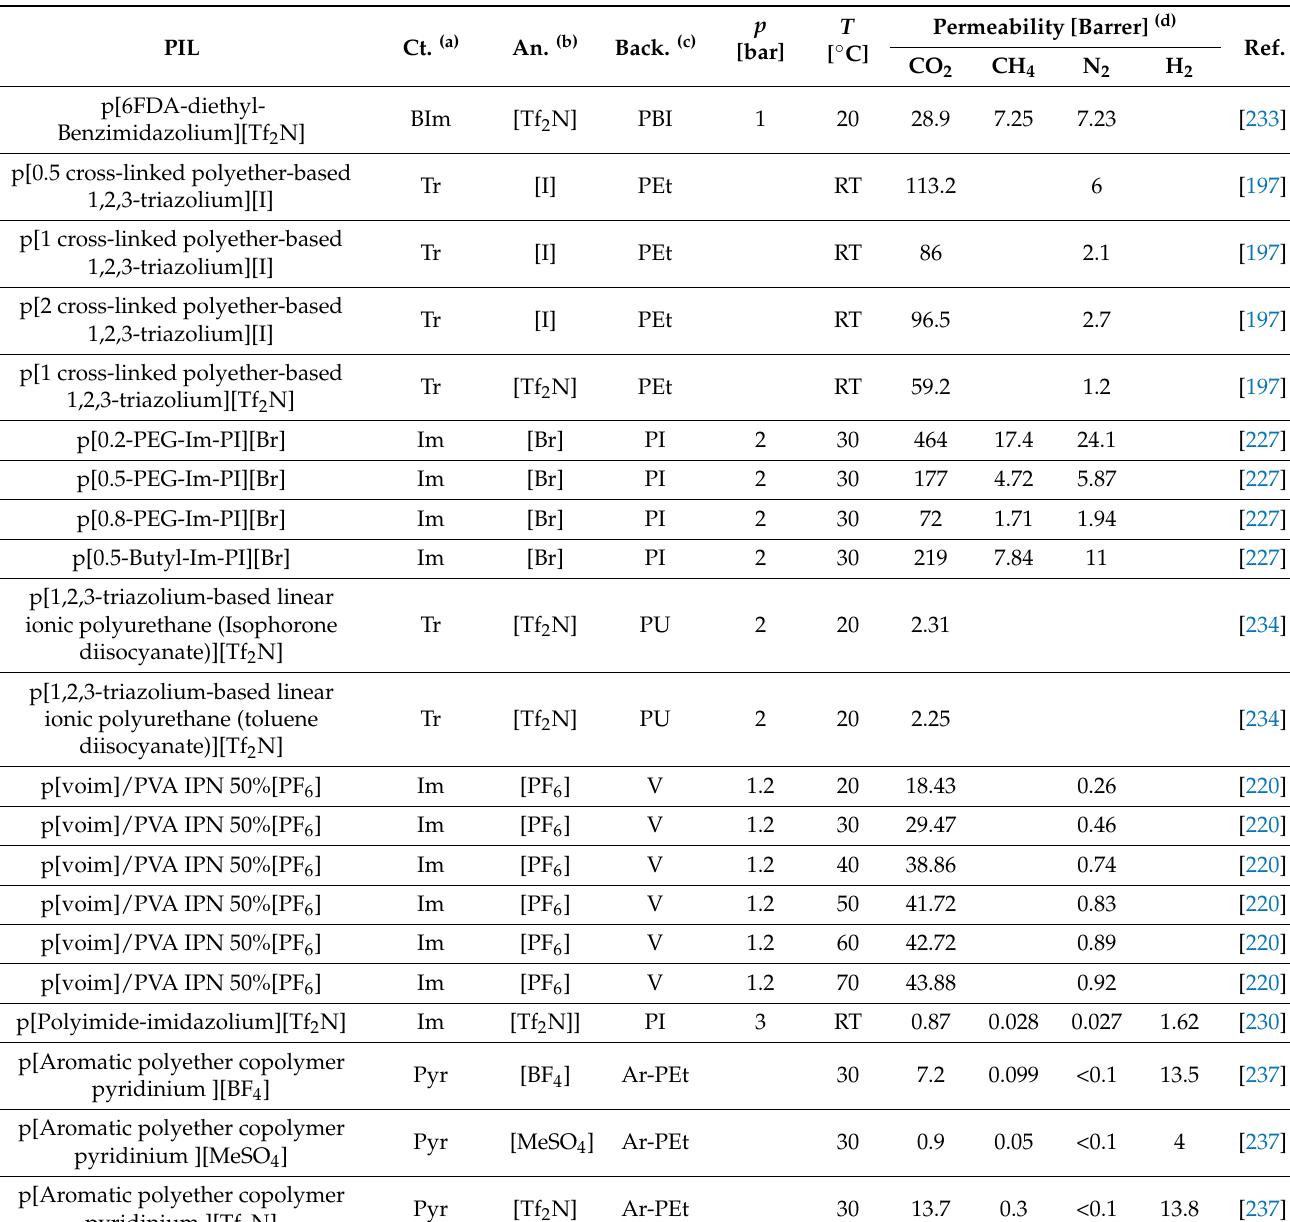
(a) Ct. = Main type of cation: BIm = Benzimidazolium, Im = Imidazolium, Pyr = Pyridinium, Pyrr = Pyrrolidinium, Tr = Triazolium; (b) An. = Anion type; (c) Back. = Polymer Backbone nature: Ac = Acetylene, Acry = Acrylate, Ar-PEt = Aromatic polyether, PBI = Polybenzimidazole, PEt = Polyether, PU = Polyurethane, PI = Polyimide, PIm = poly-Imidazole, Pyrr = Pyrrolidinium, Styr = Styrene, V = Vinyl. (d) 1 Barrer = 10 − 10 cm